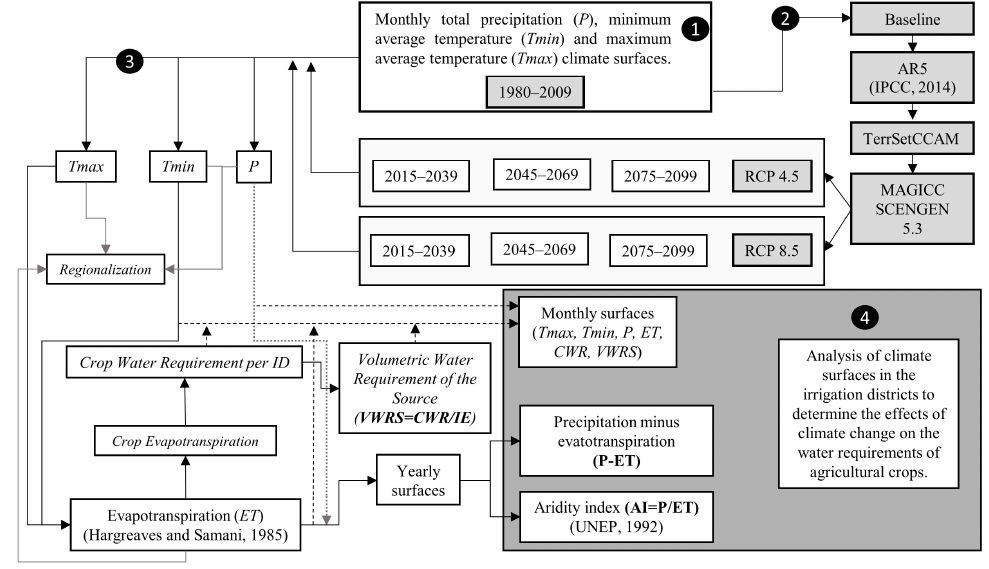
Figure 3. Methodological diagram.